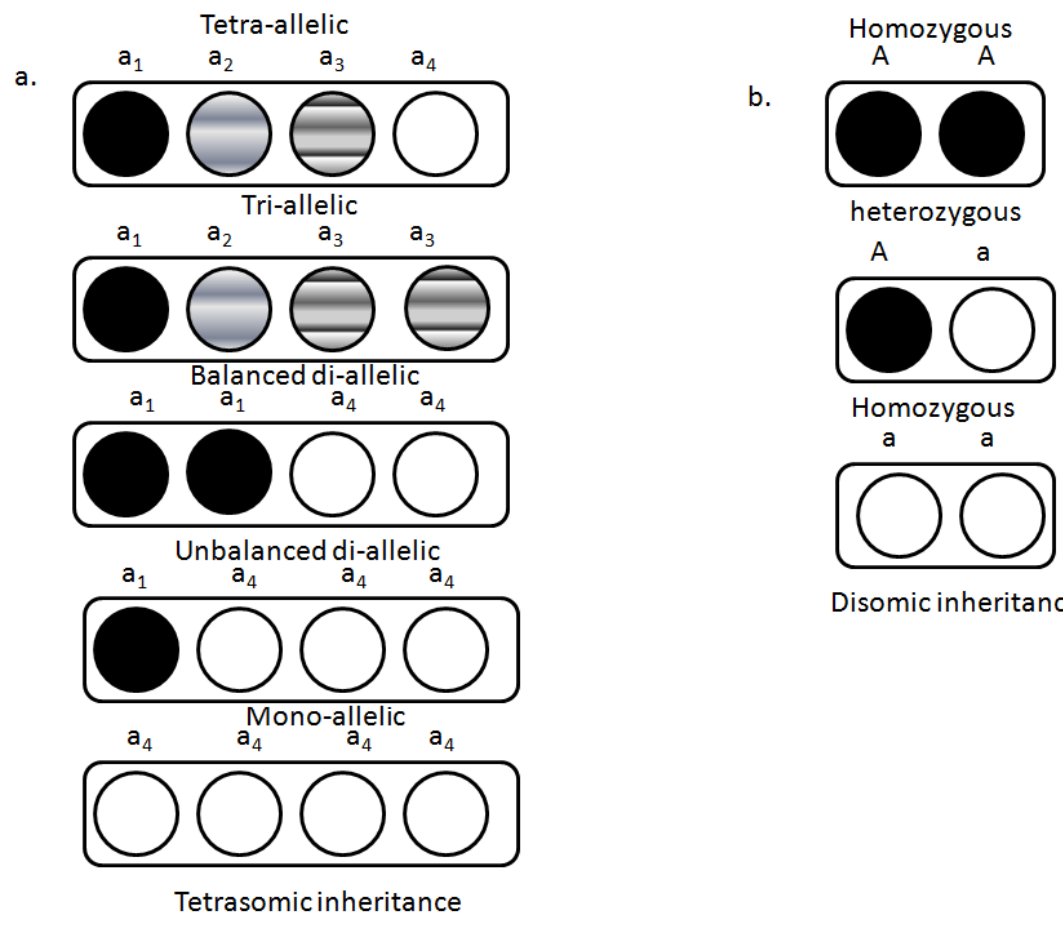
Figure 2. Polysomic tetraploid genotypes assuming sub-functionalization ( a ) and genotypes following disomic inheritance in a diploid ( b ).